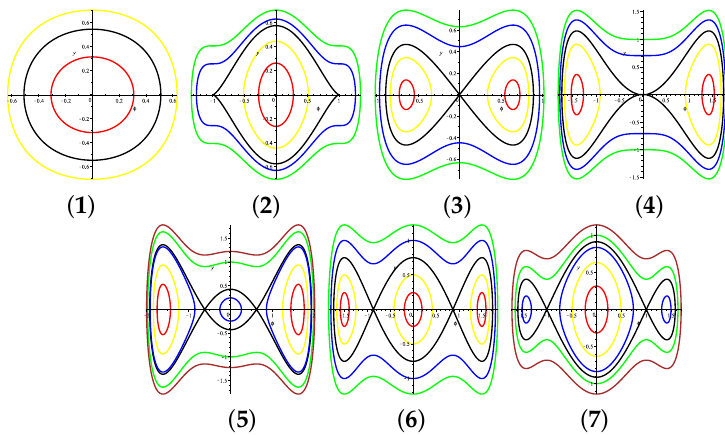
Figure 1. Phase portraits corresponding to system (5) under c > 0, α − 2 β = 0, a − 2 α > 0. ( 1 ) ∆ < 0 or